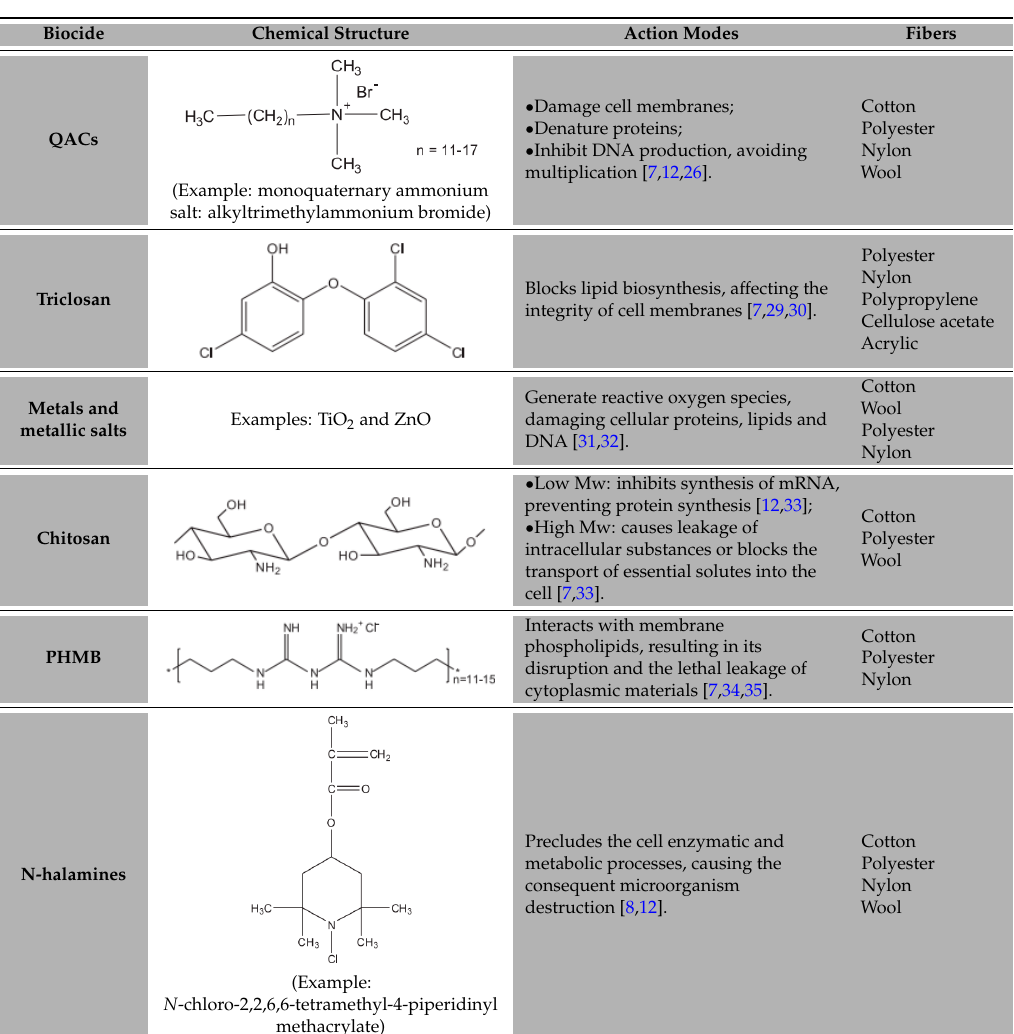
Table 2. Commercially available antimicrobial isolated